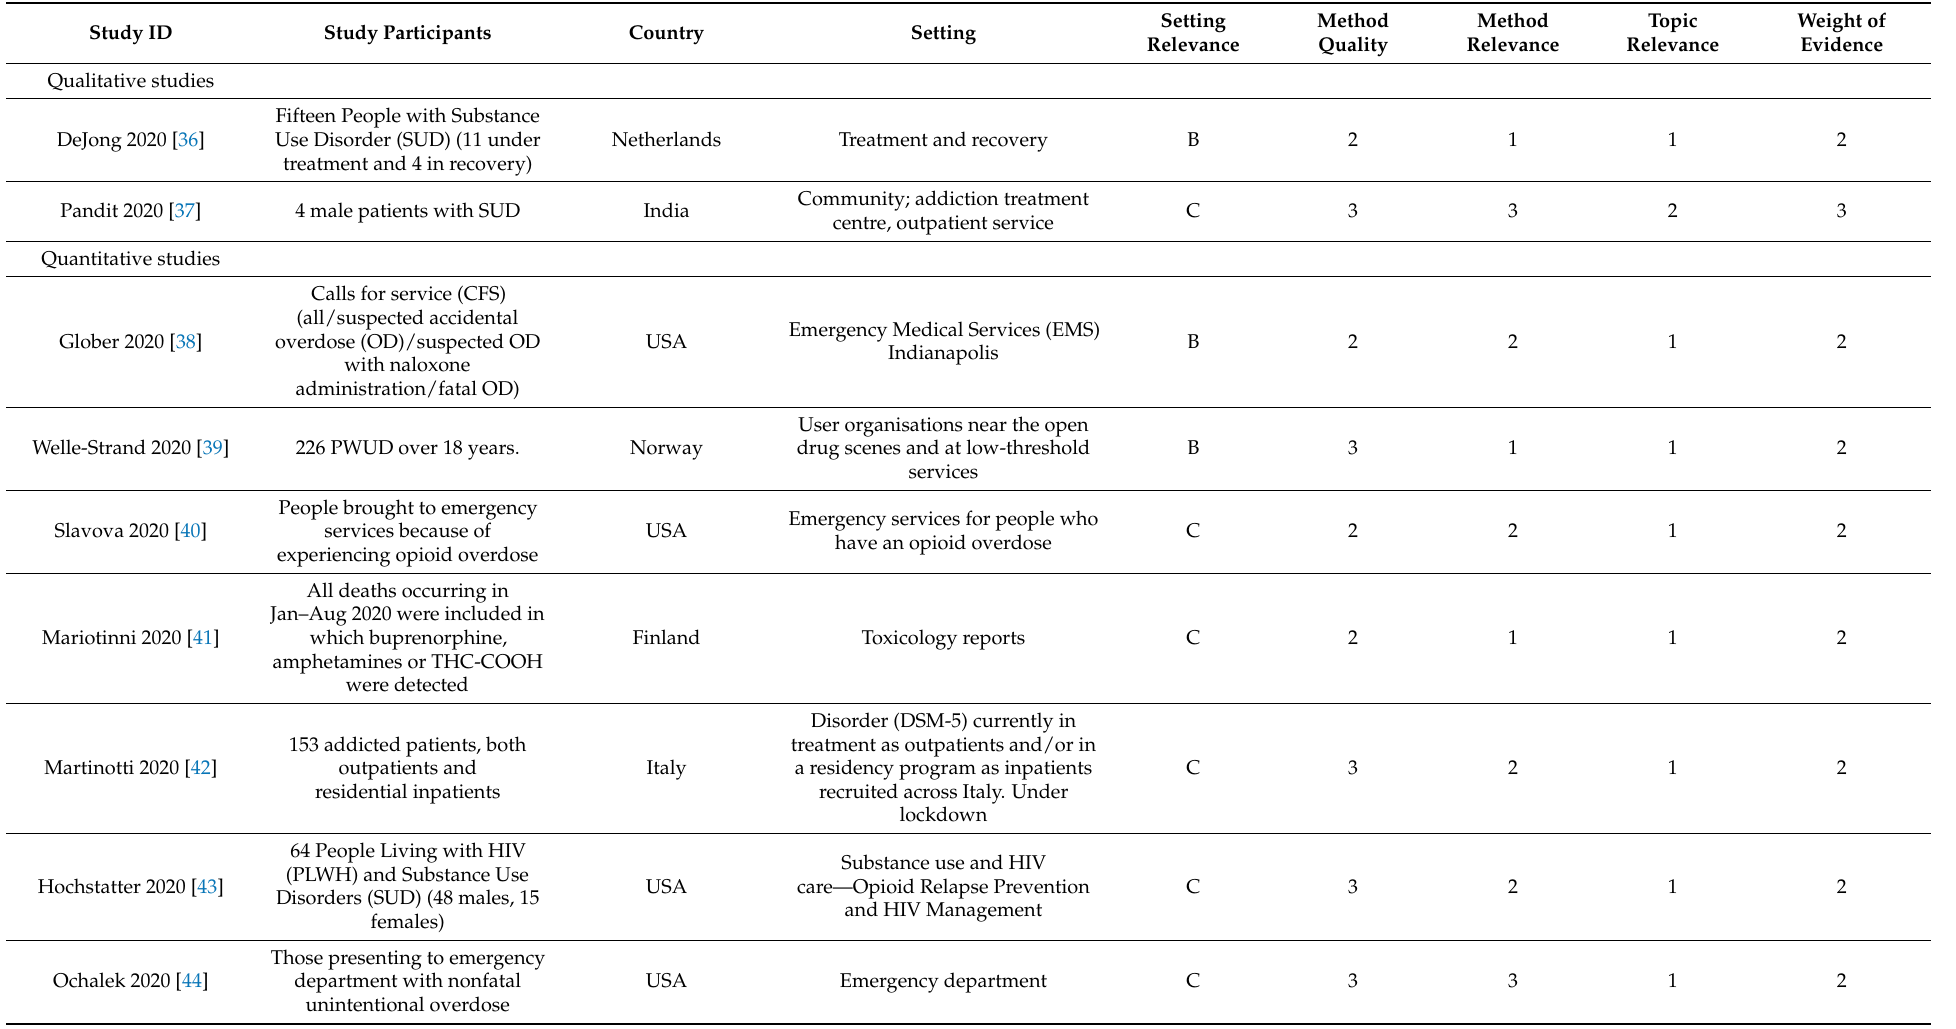
Table 3. Characteristics of included studies (ordered by weight of evidence and setting